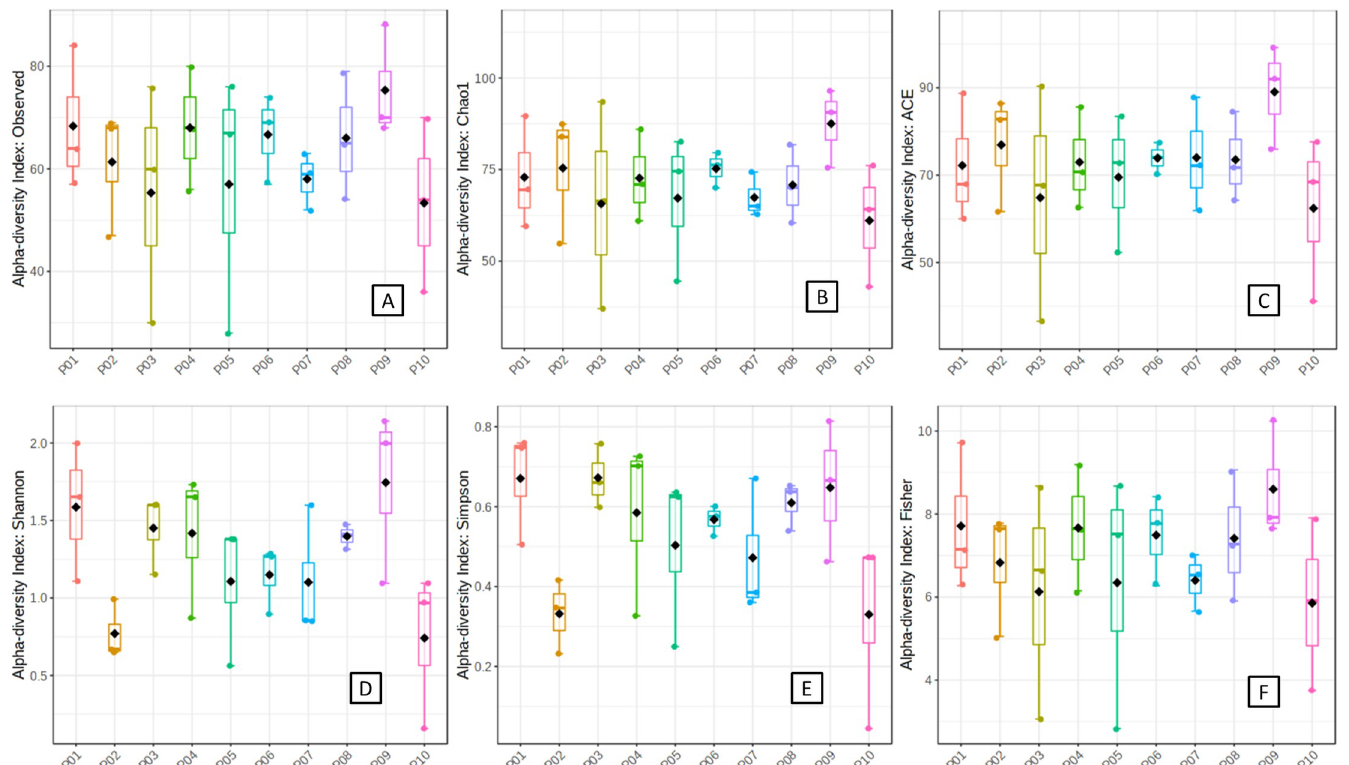
Fig 12. Alpha diversity indices of nasal bacterial population of ten health care professionals at three different time points (A) Observed (B) Chao1 (C) ACE (D) Shannons (E) Simpsons and (F) Fisher. The data were compared by one way ANOVA at p � 0.05. P01-P10 plotted on the X-axis represents the ten individuals sampled consecutively. Corresponding alpha diversity ı´ndices are plotted on the y-axis.